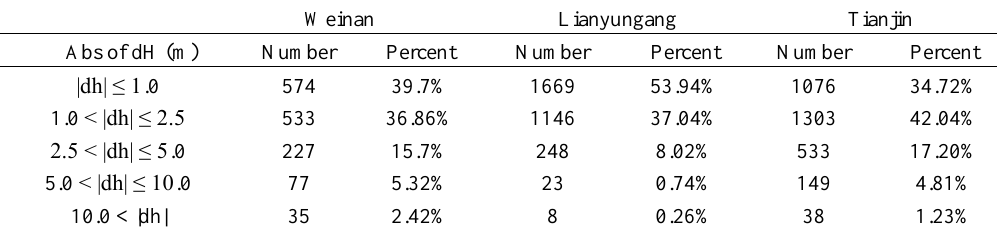
Table 4. Segmentation point numbers for elevation differences in the three experimental